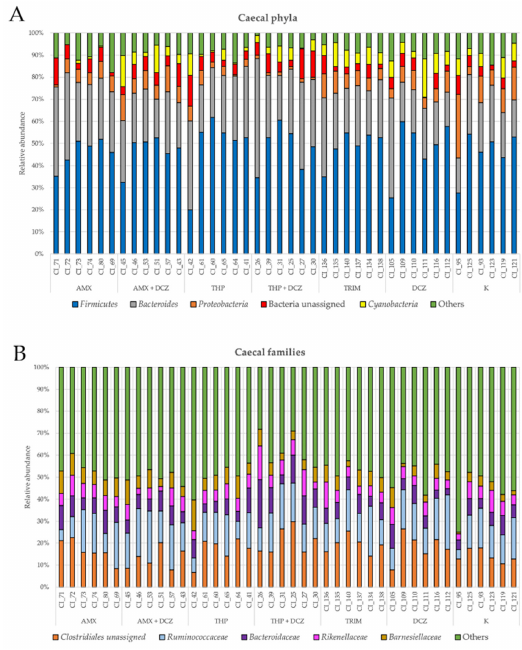
Figure 3. Relative abundance at the phylum ( A ) and family level ( B ) in caecum. Specific legends are reported for each bar plot.